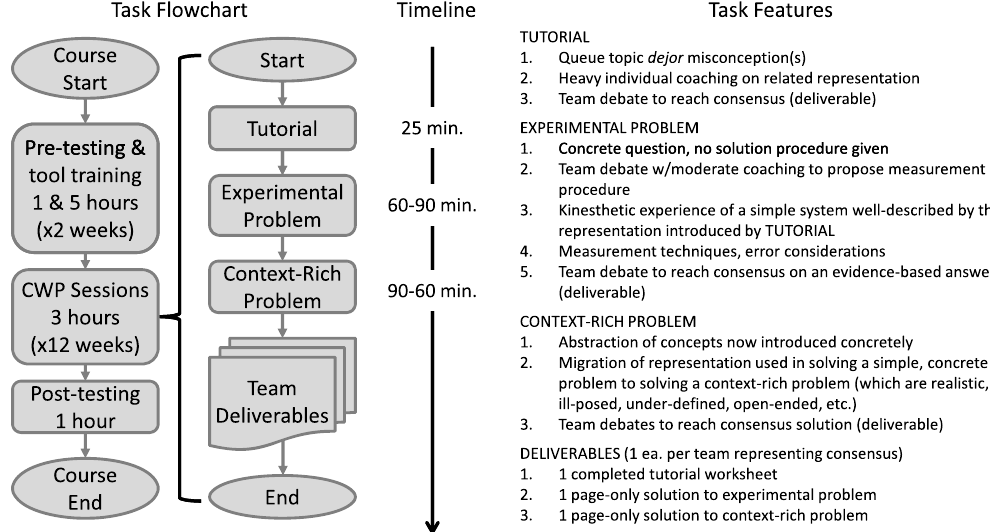
FIG. 5. A flowchart representation, timeline, and description of tasks in the three-hour Collaboration